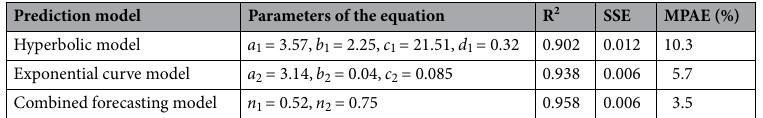
Table 4. Cumulative differential settlement prediction model of monitoring point 3.